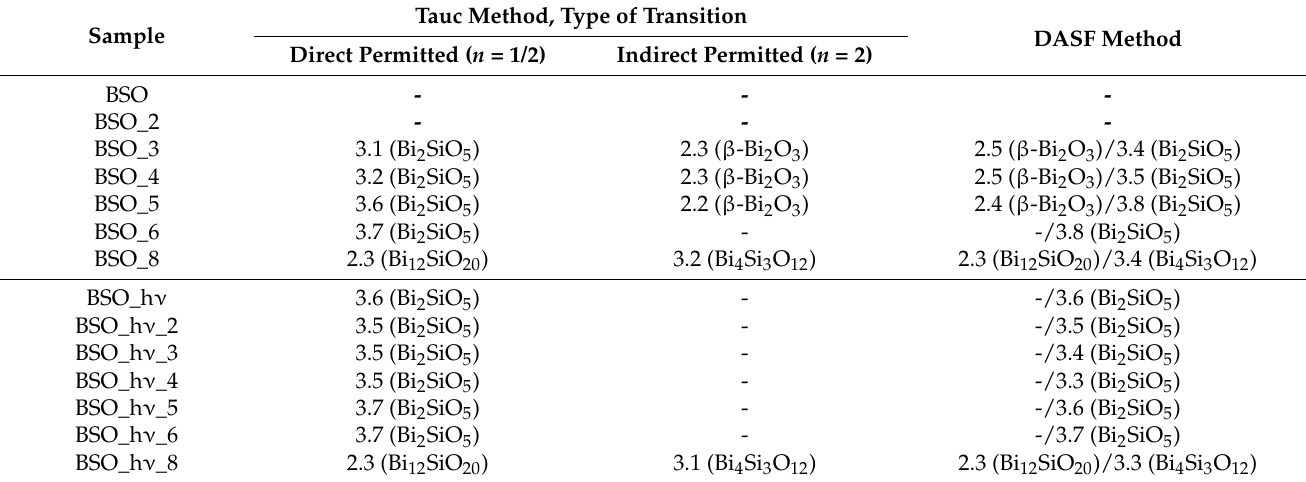
Table 1. E g values (eV) for BSO and BSO_h ν group samples obtained from DRS data.